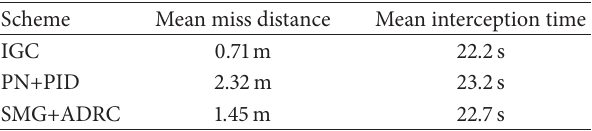
Table 2: Mean miss distance and interception time of the three schemes in Scenario 2.